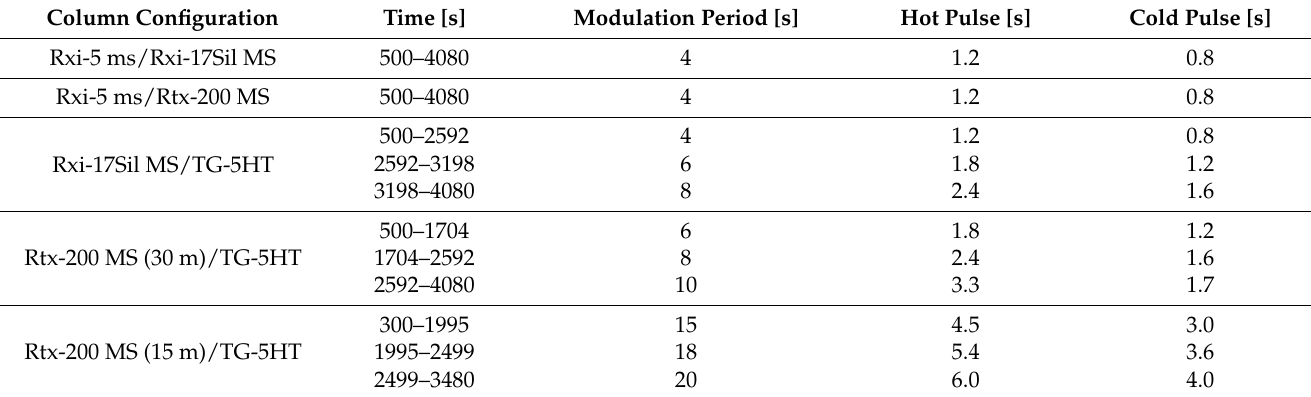
Table 1. Modulation periods and durations of hot and cold pulses for different column configurations. Column Configuration Time [s] Modulation Period